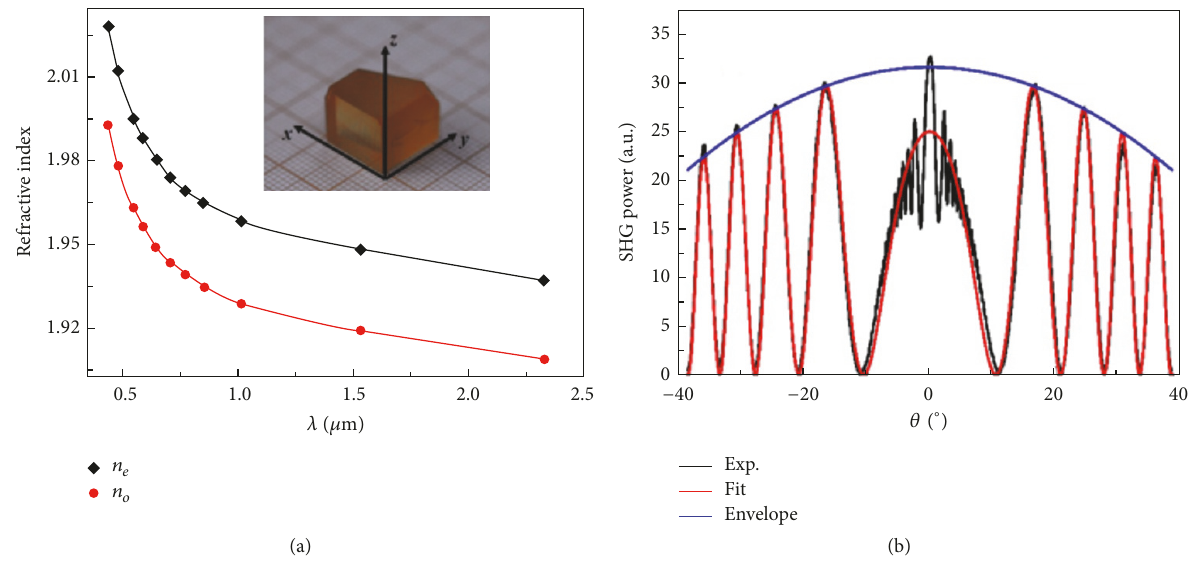
Figure 7: (a) Measured principal refractive indices 𝑛 𝑜 and 𝑛 𝑒 plotted as a function of wavelength. The insert picture shows the oriented centimeter-size LGN prism. (b) The Maker Fringes pattern 𝑑 11 of LGN. Reprinted with permission from [17]. Copyright 2016 Optical Society of America.